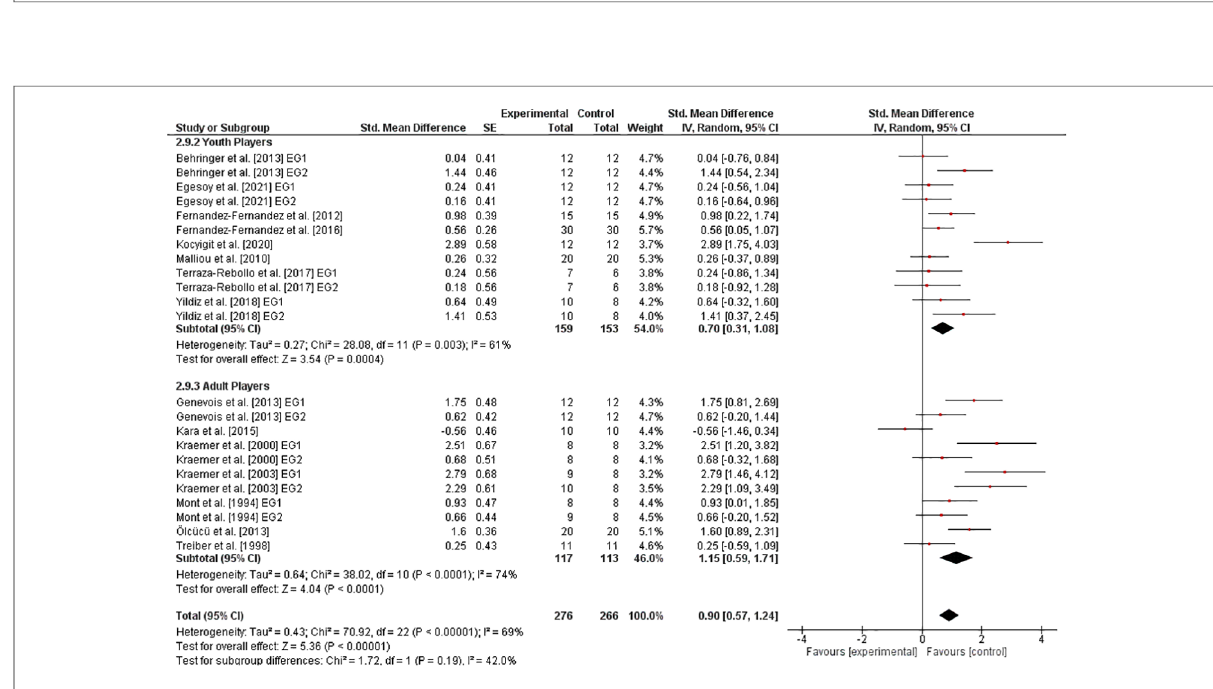
FIGURE 9 Effects of athletic training on measures of fl exibility (e.g., sit-and-reach test) in healthy youth tennis players. CI =con fi dence interval, df =degrees of freedom, SE =standard error, IV =inverse variance.